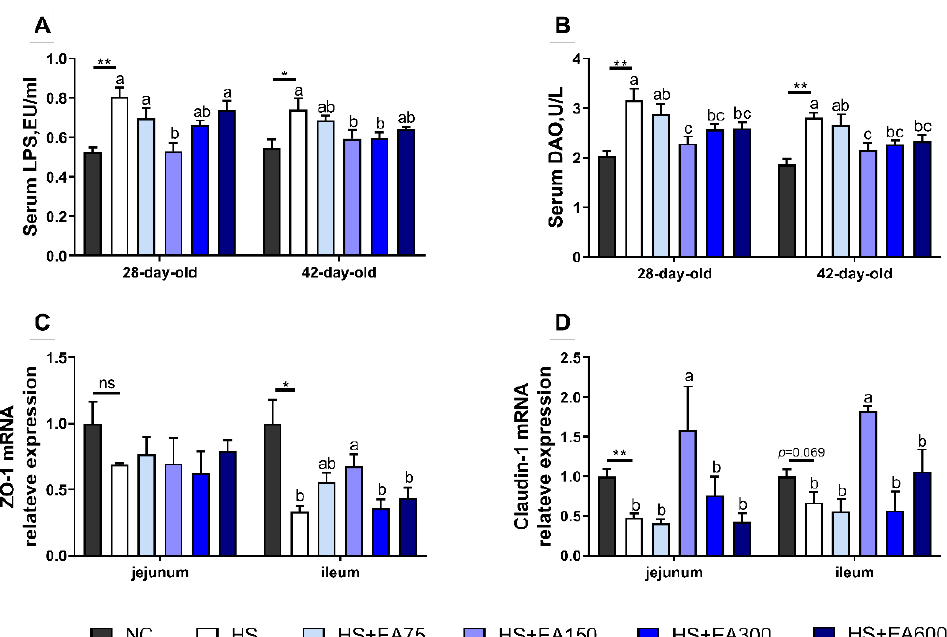
Figure 5. Effects of dietary EA on intestinal permeability markers in serum and mRNA levels of tight junction proteins in the intestine of heat-stressed broilers. ( A ) Serum LPS, lipopolysaccharide. ( B ) Serum DAO, diamine oxidase. ( C ) ZO-1, zonula occludens 1. ( D ) Claudin-1. Data are presented as mean ± SEM (n = 6). NC (negative control) represents the broilers supplemented with a basal diet at normal temperature (23 ± 2 ◦ C). The broilers in the 5 experimental groups were supplemented with basal diets containing different levels of EA (0, 75, 150, 300, and 600 mg/kg) at HS temperature (35 ± 2 ◦ C), which are represented as HS, HS + EA75, HS + EA150, HS + EA300, and HS + EA600, respectively. Shared superscript letters indicate no significant difference ( p > 0.05). “*” indicates a significant difference between groups where p < 0.05. “**” indicates a significant difference between groups where p < 0.01. “ns” indicates a no significant difference between groups where p > 0.05.